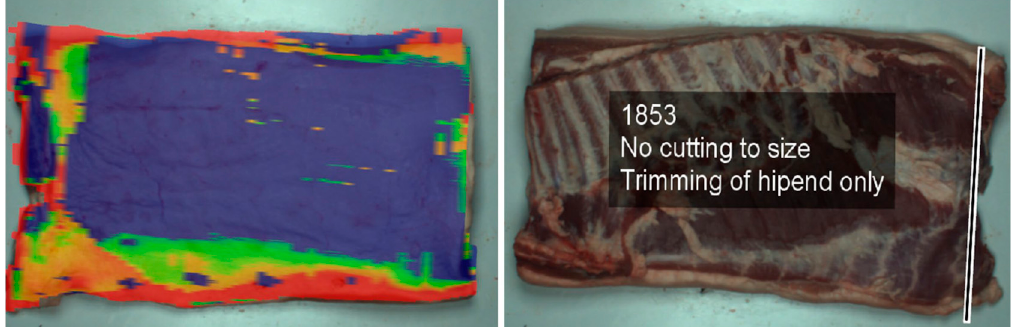
Figure 7. An AR-assisted technique for base trimming [59].